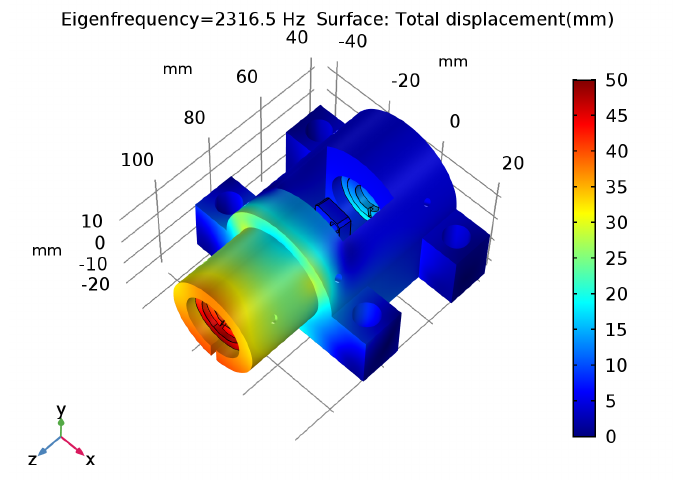
Figure 5. The frequency of the first lateral rocking eigenmode is 2316 Hz.